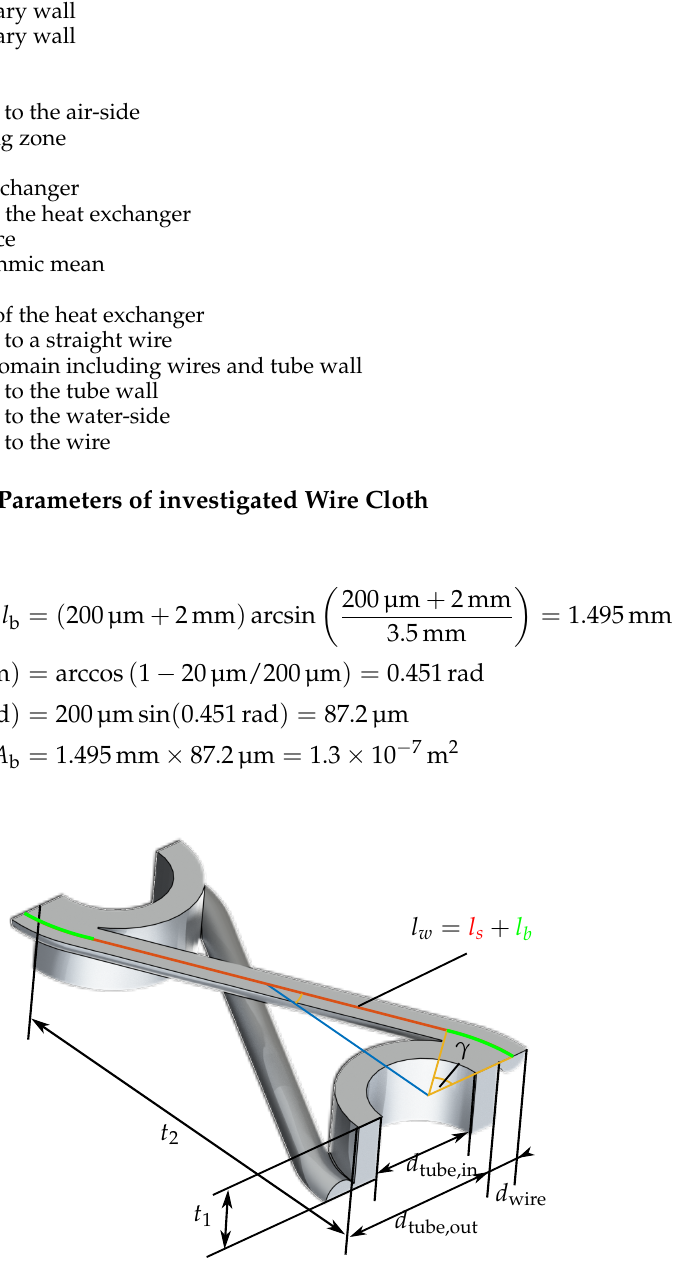
Figure A1. Geometry of the woven wire heat exchanger, diameters and